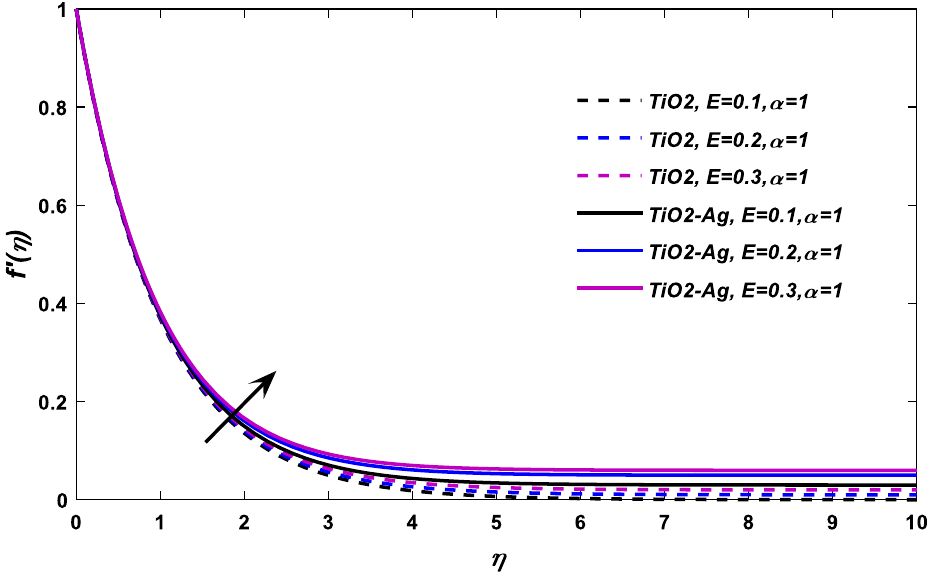
Figure 8. E versus velocity field when M = (cid:31) = 0.1, φ 1 , φ 2 = 0.02, Pr = 21.